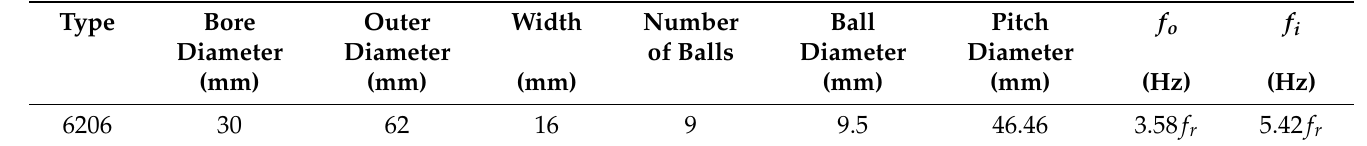
Table 2. Parameters of